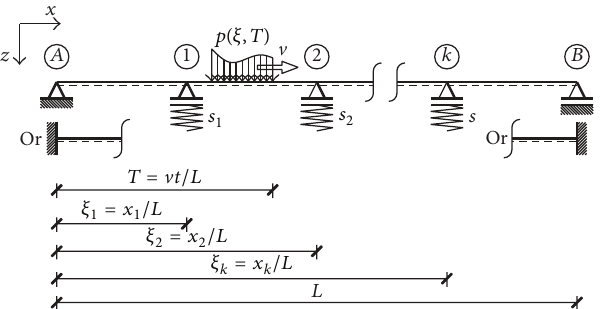
Figure 7: Multispan continuous beam with elastic mid-span supports.